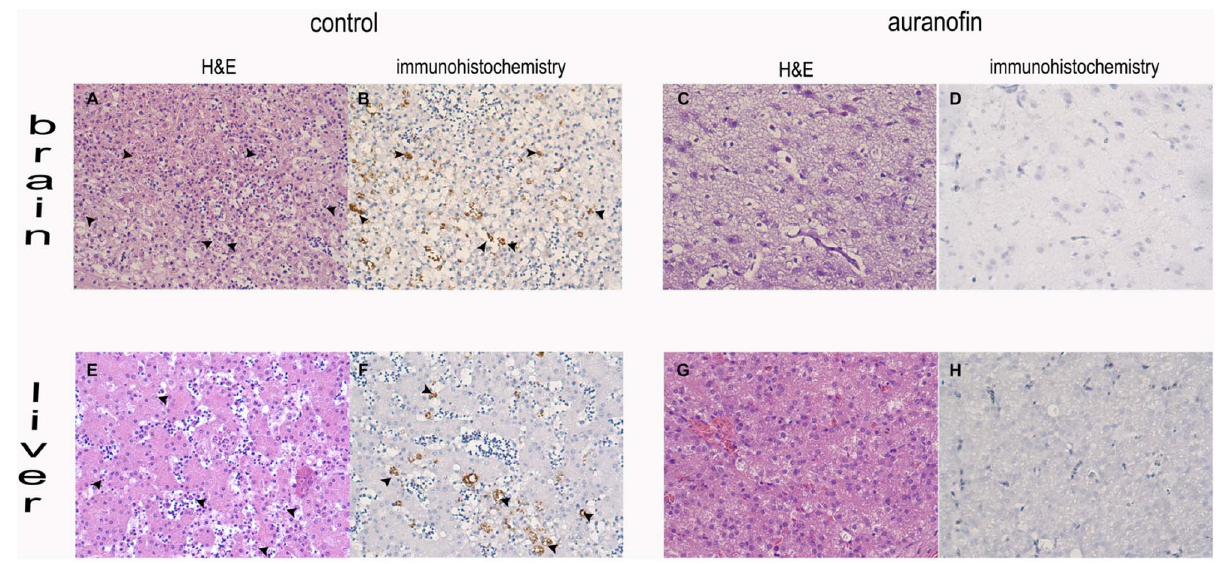
Figure 4. Hematoxylin & eosin histopathology and immunohistochemistry of brains and livers. Arrows point at parasites. A, B, E, F: control tissue with substantial amount of inflammation. C, D,G,H: tissue from auranofin-treated embryos.